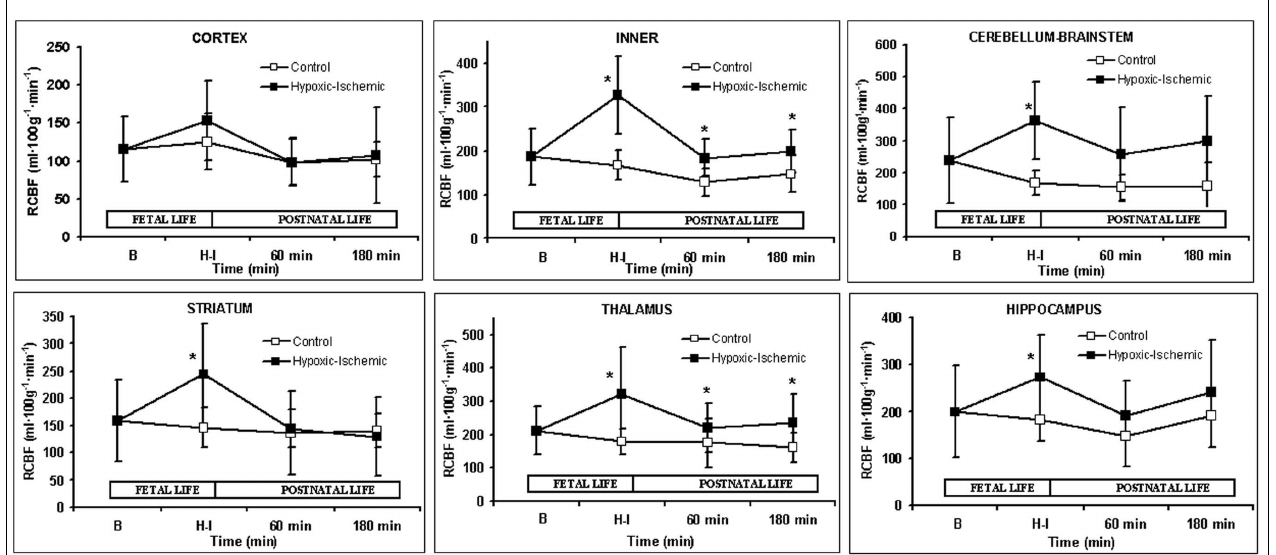
FIGURE 1 | Regional cerebral blood flow (mL100g − 1 min − 1 ). Data are expressed as mean ± SD. Mean values for both control (open square) and hypoxic–ischemic (close square) groups are represented as function of time; Baseline (B), Hypoxic–Ischemic (HI), 60 and 180min points. * p < 0.05 vs. control group (one-factor ANOVA).